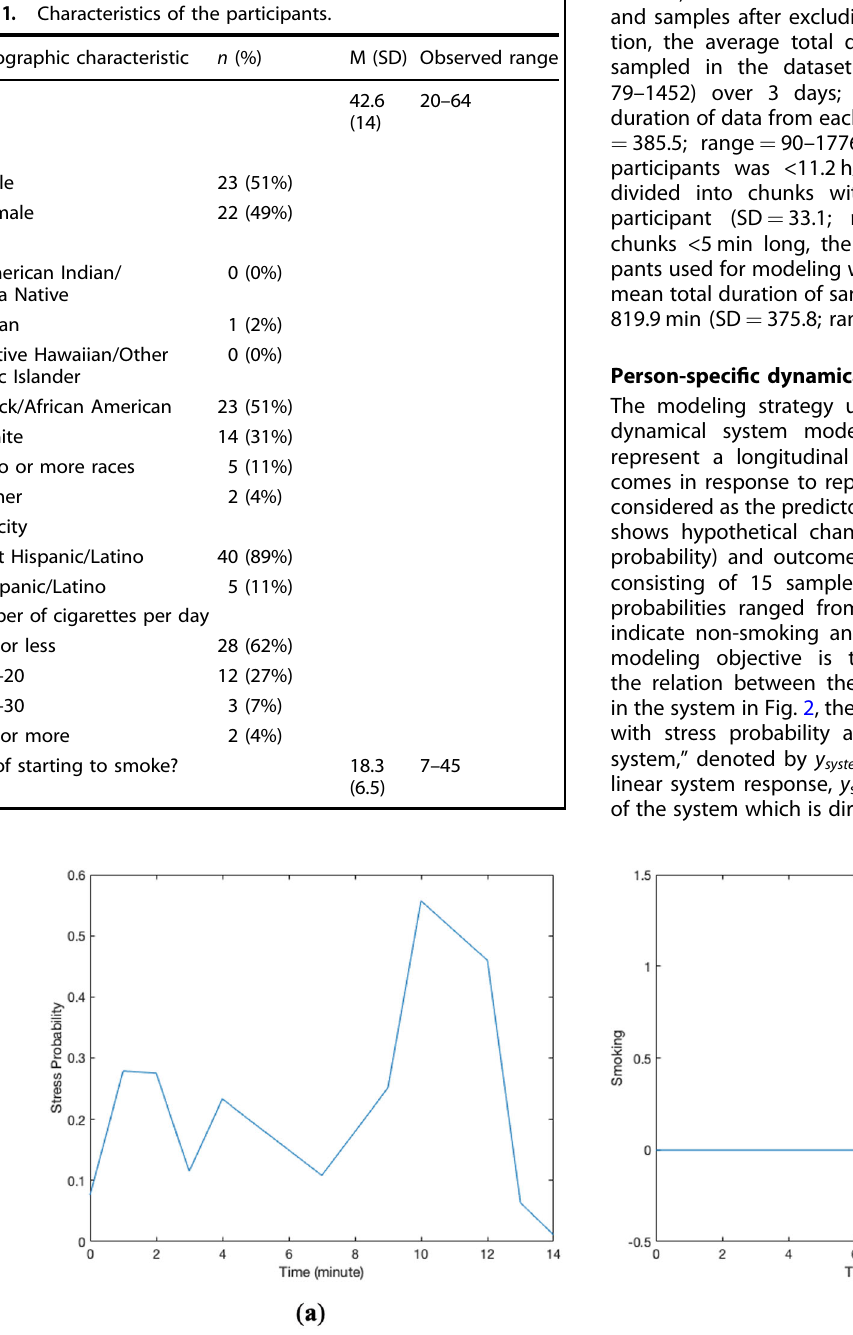
Fig. 1 Data chunks are uninterrupted time series for variables in the system. These two plots represent changes in a stress probabilities and b a binary smoking outcome for one data